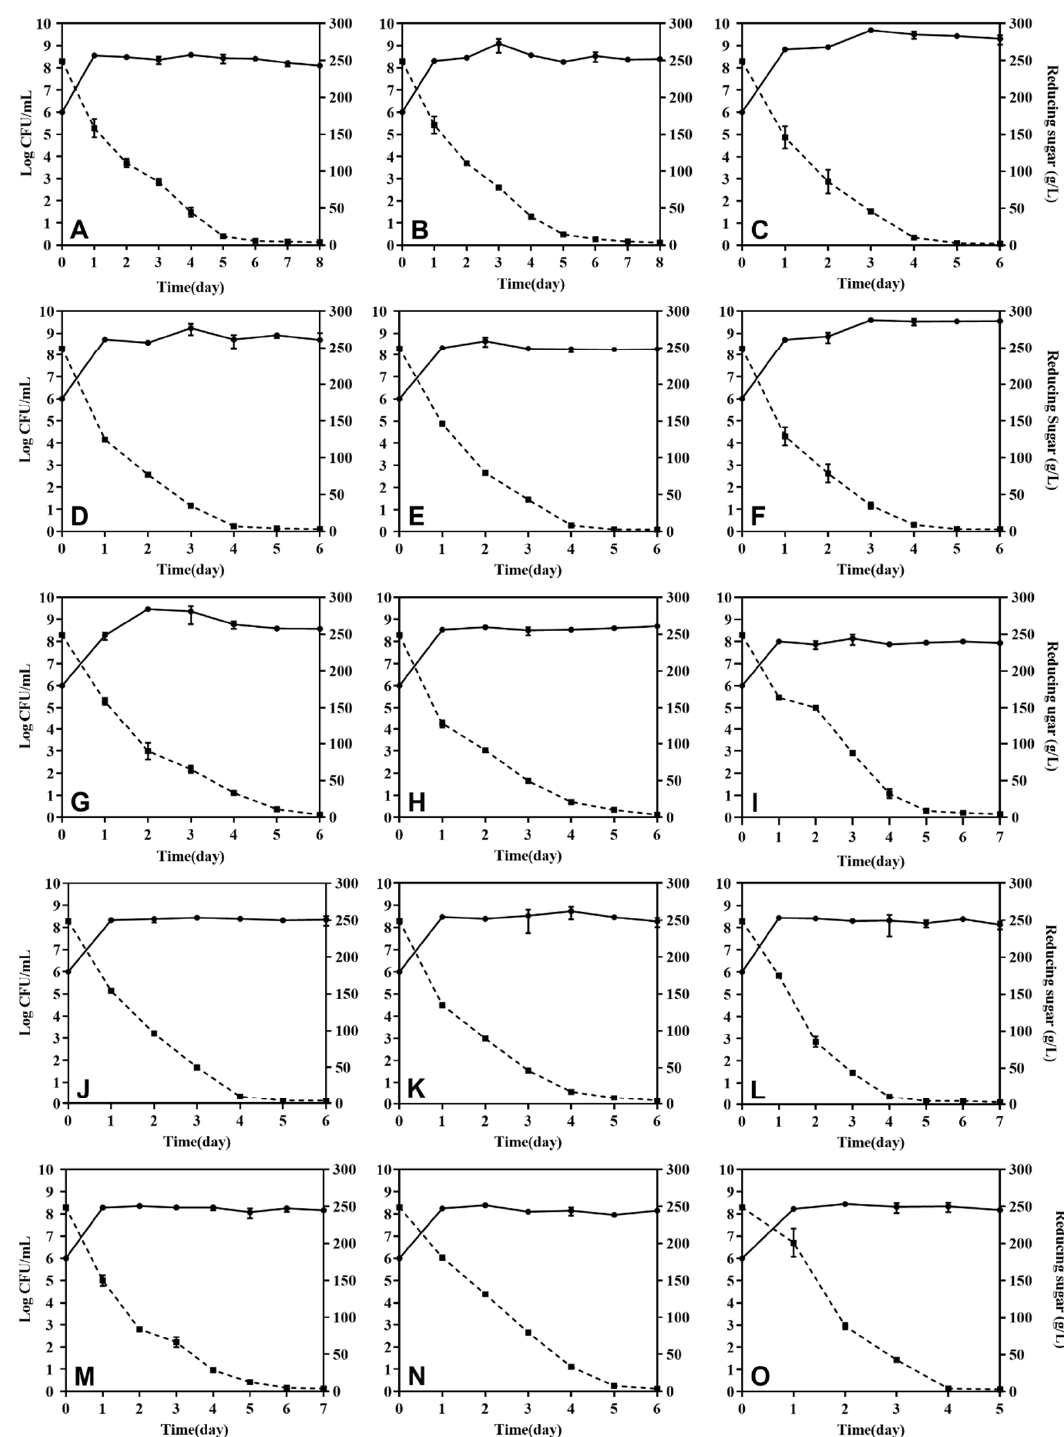
Figure 4. The growth curves and sugar consumptions of the selected S. cerevisiae strains during pure fermentations (the solid line represents the growth curve; the dashed line represents the sugar consumption curve; ( A ): FSC, ( B ): F4-13, ( C ): F5-7, ( D ): F5-9, ( E ): F5-12, ( F ): F5-18, ( G ): F5-19, ( H ): F5-21, ( I ): F6-8, ( J ): F6-23, ( K ): F9-23, ( L ): SXY-4, ( M ): HT-10, ( N ): ZXY-17, ( O ): MXY-19).